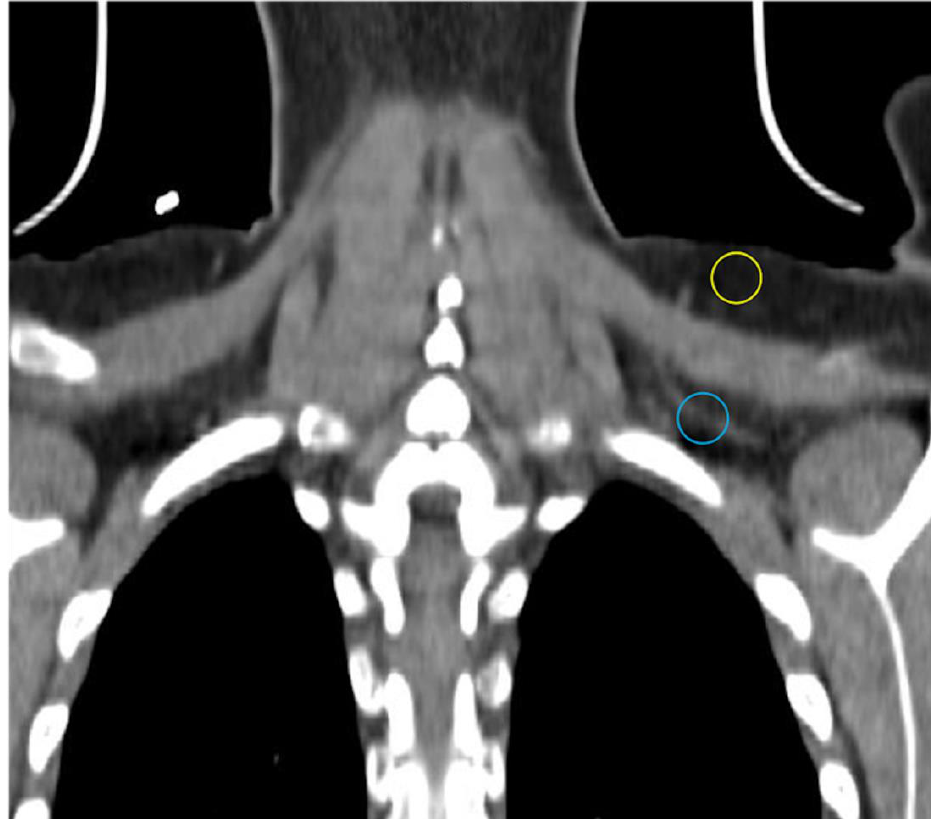
Figure 2. CT showing di ff erent density and vascularity of BAT versus WAT. Subcutaneous WAT with a darker appearance on conventional display and fewer vessels (yellow circle) compared with BAT (blue